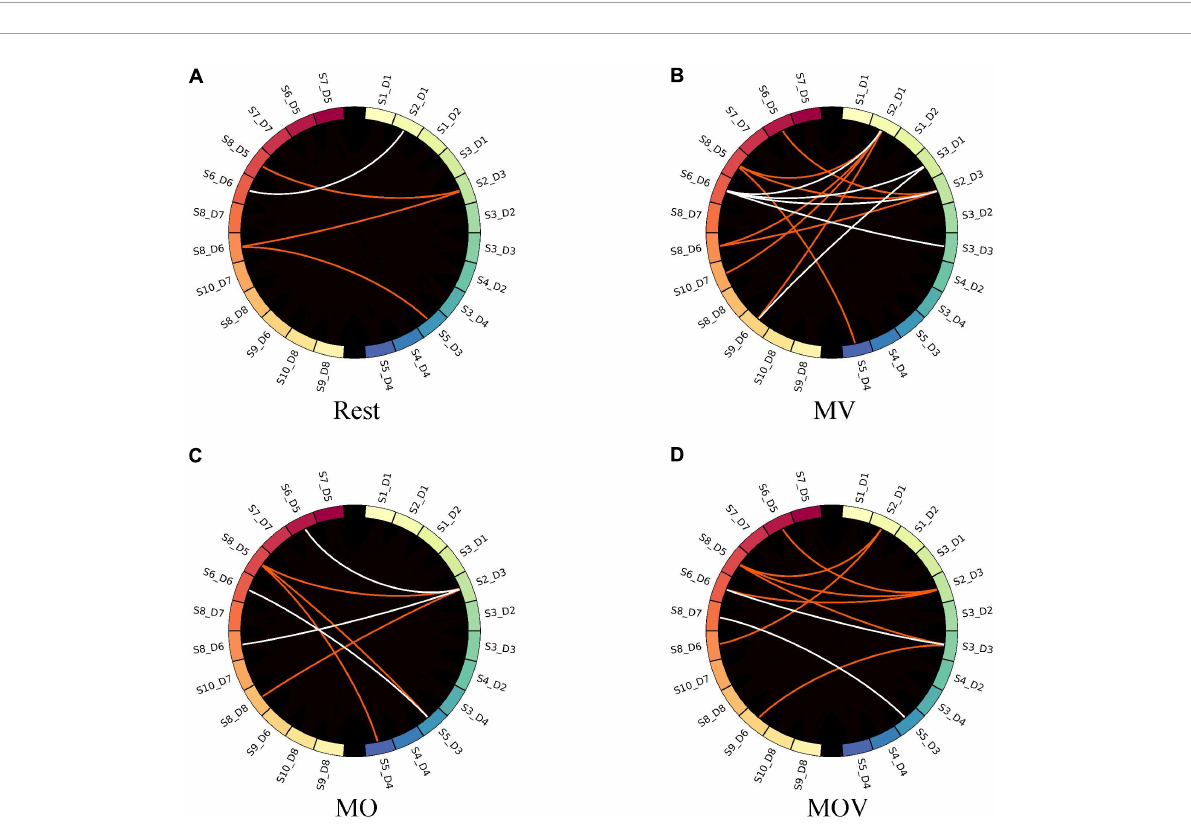
FIGURE10 Causal network visualized. The subplots (A–D) represent the brain causal network maps under the four tasks, Rest, MV, MO, and MOV. The left and right halves of each subplot represent the 12 fNIRS channels in the left- and right-brain regions, respectively. The red and white colors represent the flow of information from the right to left brain and the left brain to right brain, respectively.